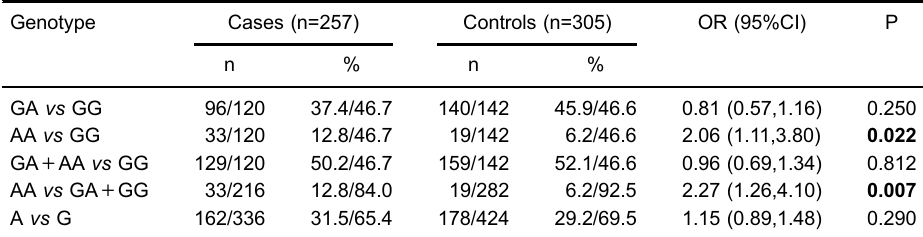
Table 2. Logistic regression analysis of associations between TNF- a rs1800629 polymorphism and risk of